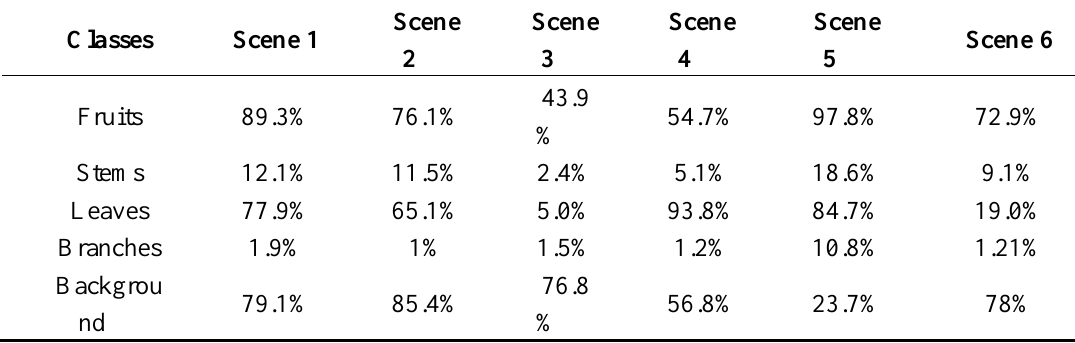
Table 6. Precisions for each class and for each scene.